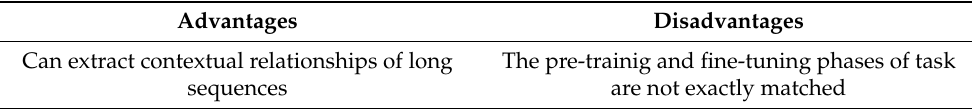
Table 6. The advantages and disadvantages of